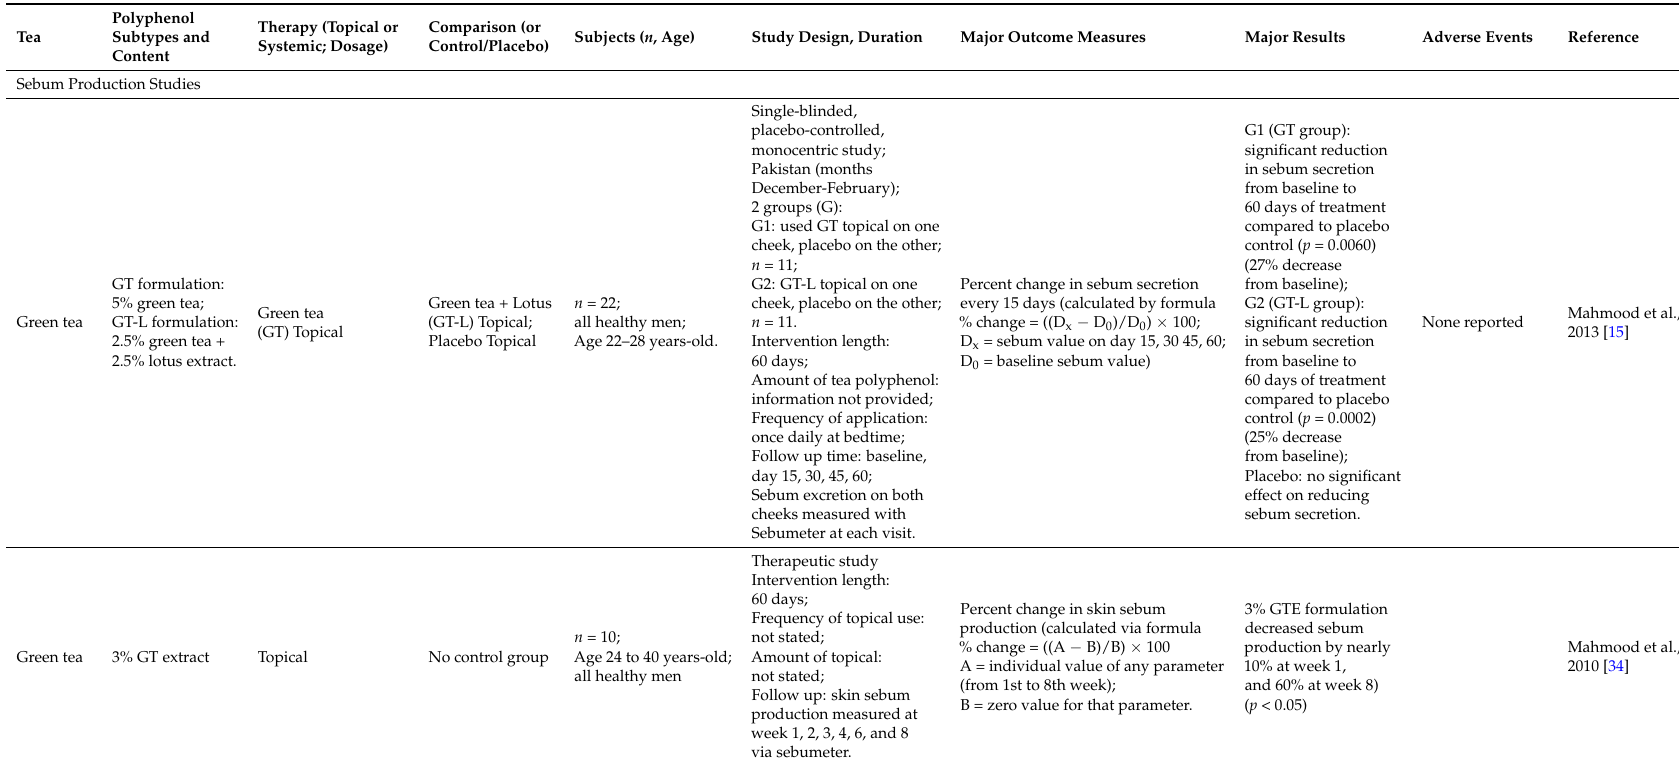
Table A1. Tea polyphenol